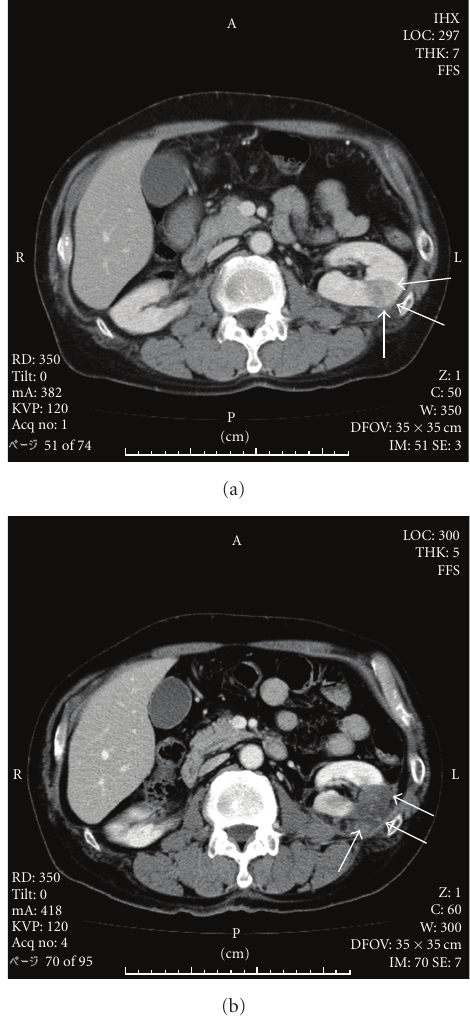
Figure 2: (a) Contrast-enhanced CT showed a solid tumor of 2.5cm in diameter with weak enhancement in the left kidney (case number 5). (b) The tumor was replaced by low-density tissue without enhancement following RFA, and he was free of disease postoperatively for 12